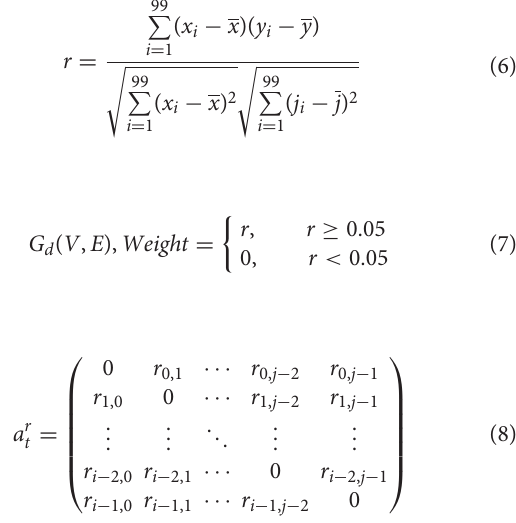
dependence, and embed spatial distance values into spatial grid matrixes (Li et al.,